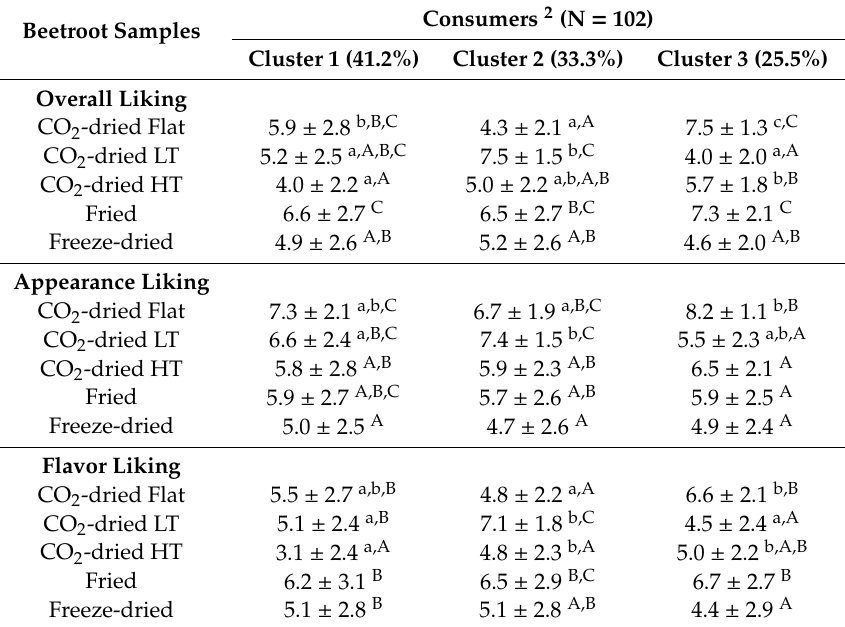
Table 2. Consumer hedonic acceptance 1 for dried beetroot